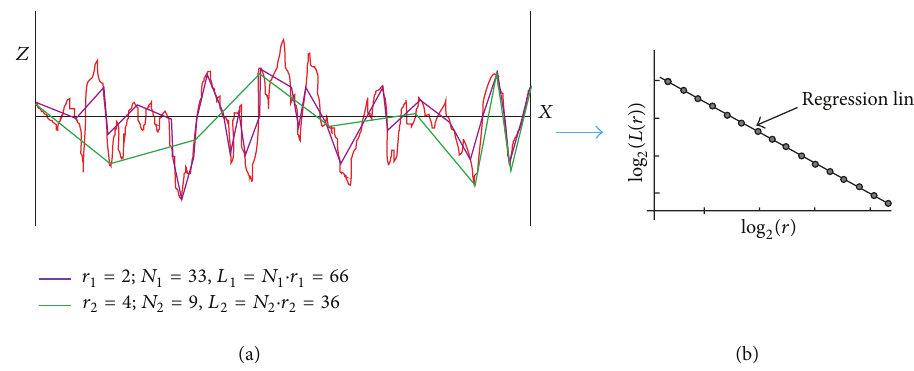
Figure 4: Estimation of the fractal dimension by the compass method.